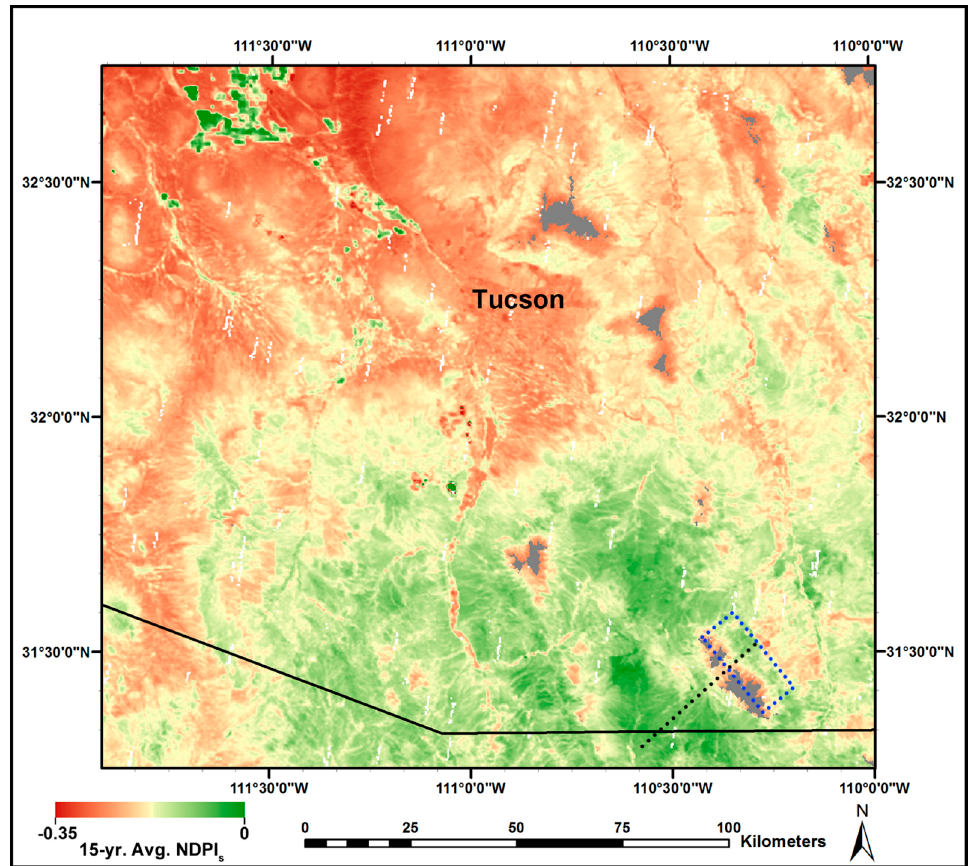
Figure 11. Image-based map of the 15-year (2000–2014) average NDPI s from MODIS (tile h08v05). Gray color indicates the data mask applied to snow-prone areas (elevation > 2134 m). White color pixels that appear in sporadic, narrow bands indicate data masks applied to missing or unreliable MODIS data. The diagonal transect and the rectangular area, indicated by the broken lines across the Huachuca Mountains, are where the image data were sampled for comparative analysis.